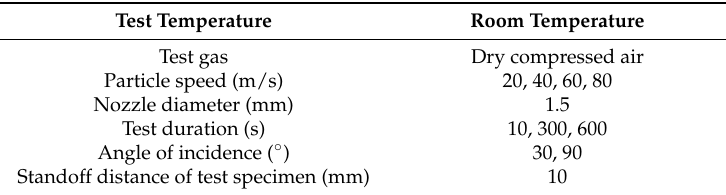
Table 2. Test parameters used for the erosion of API X100 steel.